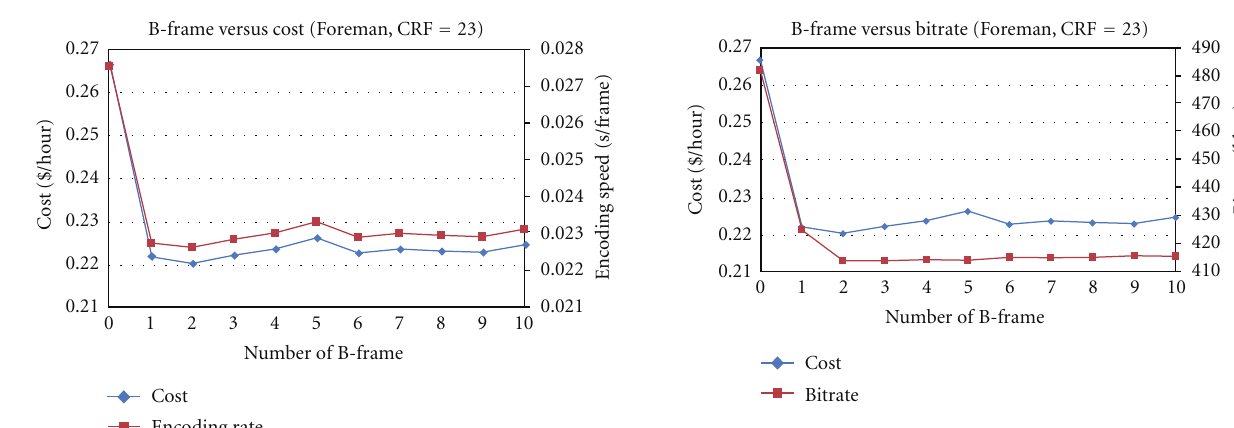
Figure 4: Bitrate and cost with varying B-frame number (Foreman, crf = 23).